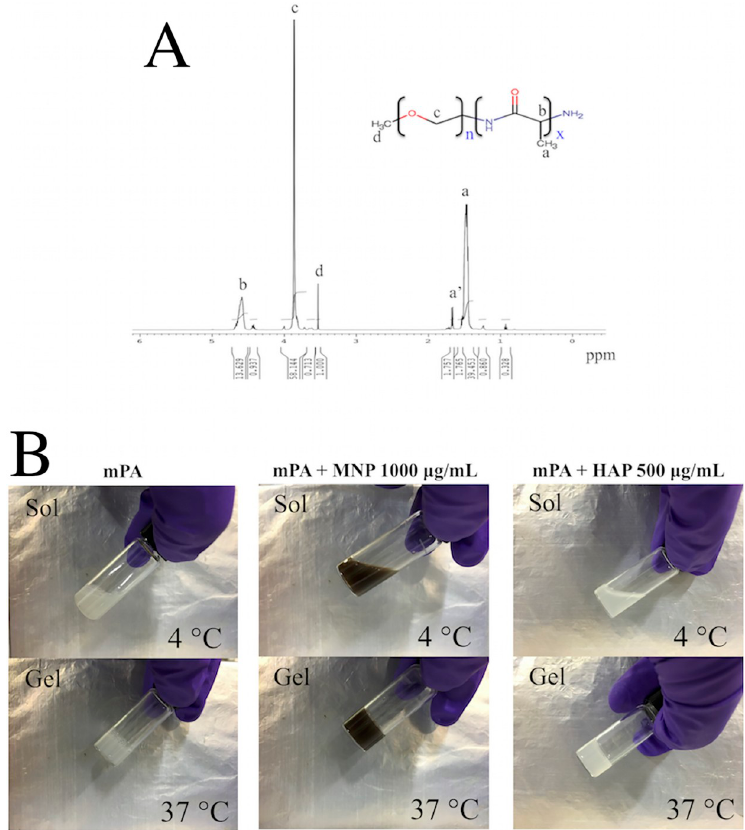
Fig 1. (A) 1 H-NMR spectrum of mPA (CF 3 COOD). (B) Photographs of sol (4˚C) and gel (37˚C) states of the injectable hydrogel solution.